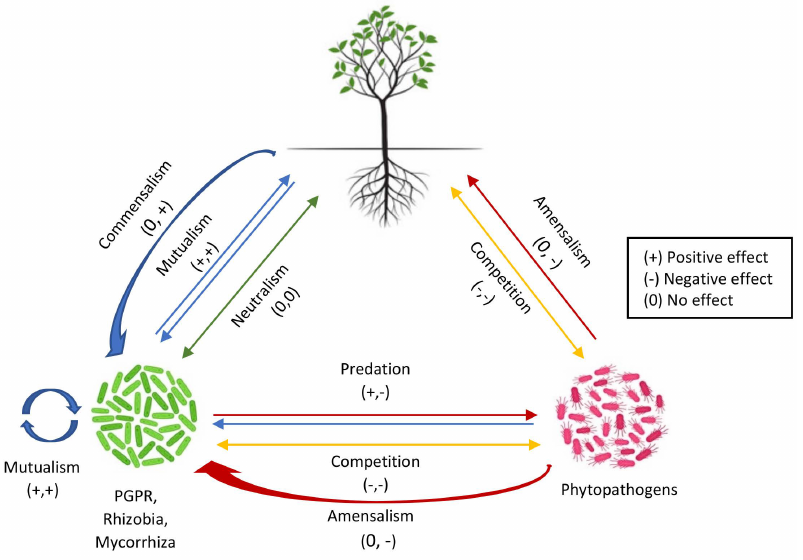
Figure 1. Schematic representation of interactions between rhizo-microorganisms and